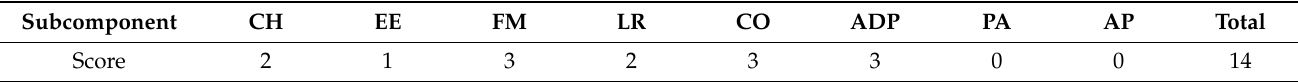
Table 10. Total scores of the eight subcomponents of